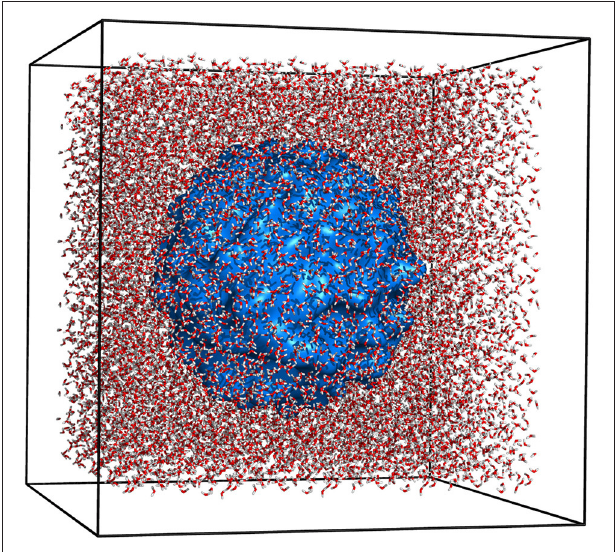
FIGURE 3 | Graphical illustration of the isolated system containing aqueous solution. Water molecules are represented as red and white sticks. The system boundary is shown as white faces with black edges. The subsystem-micelle is closed surface, blue blob in the center of the